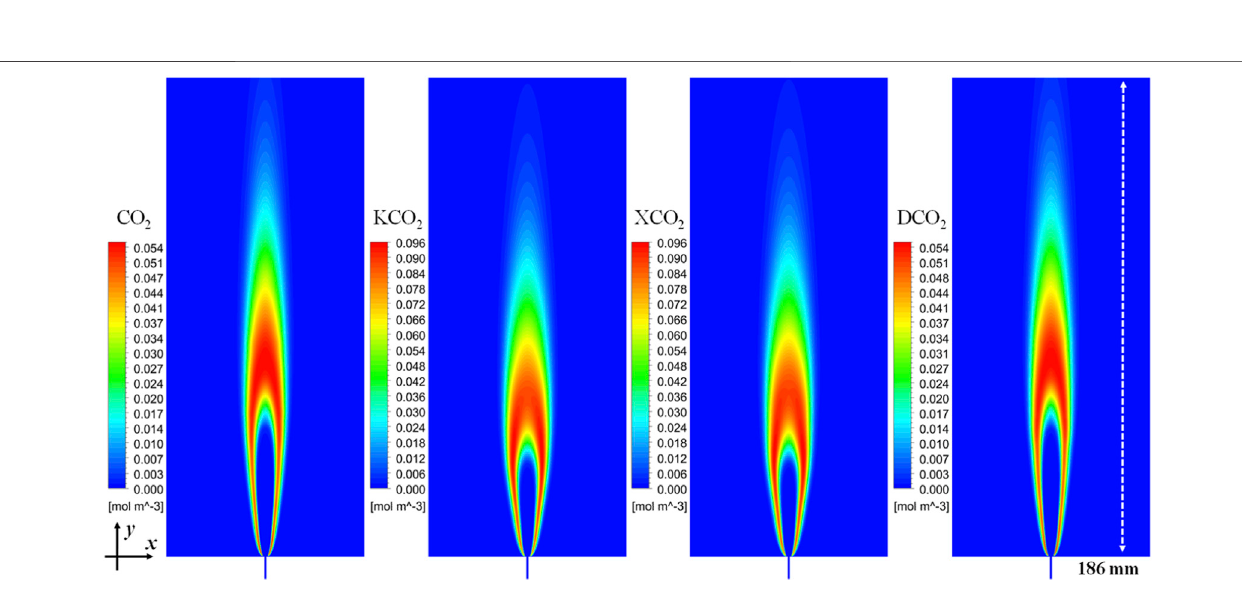
Frontiers in Energy Research |